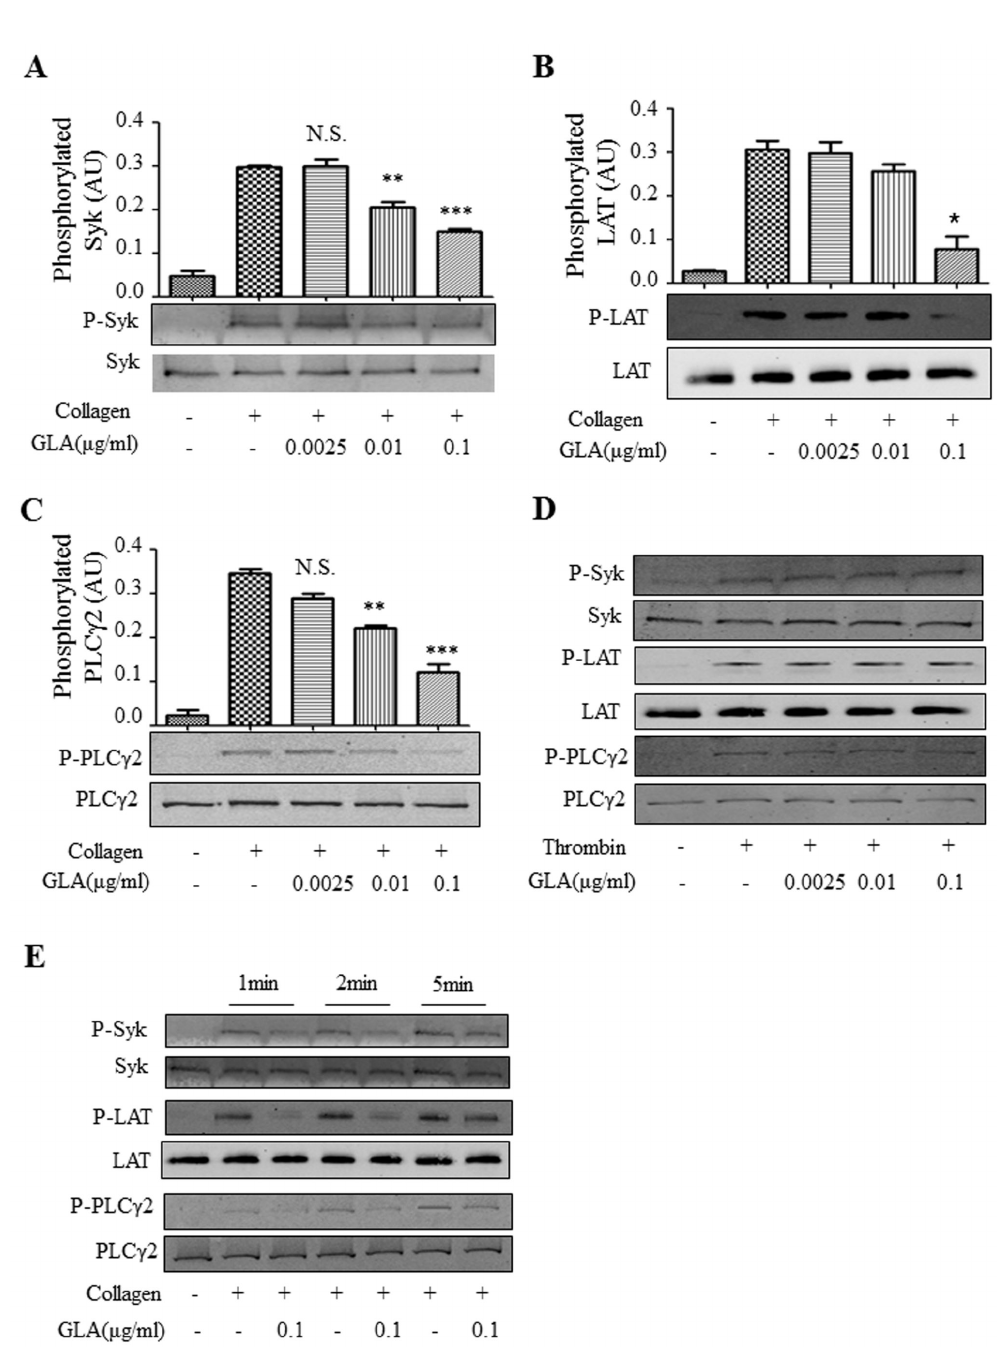
Figure 5. Influences of GLA on platelet intracellular signaling. Gel-filtered platelets (2.5×10 8 /ml) were pre-incubated with vehicle (DMSO) or GLA (0.0025, 0.01, 0.1μg/ml), and stimulated with collagen (2μg/ml) with stirring at 900 rpm in an aggregometer at 37°C for 60 seconds. Platelets were lysed, and immunoblotted using the corresponding antibodies recognizing total and phosphorylated Syk (A), total and phosphorylated LAT (B), and total and phosphorylated PLCγ2 (C). After incubation with the goat anti-rabbit IRDye 800CW or goat anti-mouse IRDye 800CW (LI-COR Biosciences, Lincoln, NE, USA), densitometric band scanning was performed using an Odyssey Infrared Imaging System (LI-COR Biosciences) (mean ± standard error, n=3). **P <0.01. ***P <0.001. N.S., not significant compared to vehicle control. The statistical significance was determined by one-way ANOVA analysis of variance with the Bonferroni post test. Same methods were used to measure the time course of GLA inhibition (D) and thrombin control (E) for the phosphorylation of the three signaling molecules in the GPVI pathway. The gels are the representatives of at least three individual experiments. doi: 10.1371/journal.pone.0085120.g005 PLOS ONE |